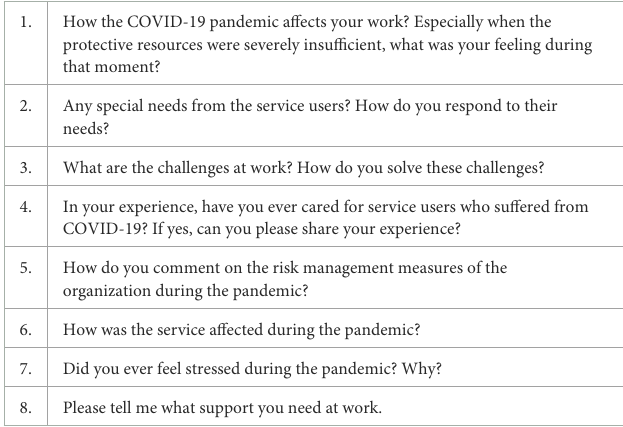
TABLE 2 The semi-structured interview guide for focus group